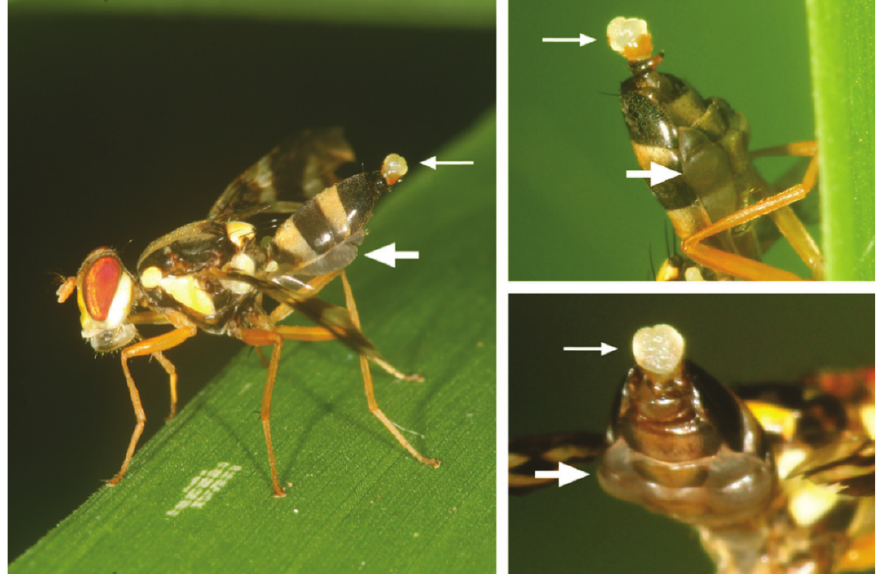
Figure 8. (Left) Typical pheromone calling posture of A. rufipes at the edge of a bamboo leaf. The male is looking downwards; the abdomen is raised; a white pouch (evaginated rectum) is visible at the tip of the abdomen (upper thin arrow); and the lateral parts of the abdomen are distended (lower thick arrow). (Upper right) Enlarged abdomen seen from the ventro-lateral position. (Lower right) Enlarged abdomen seen from the ventro-caudal position. Males searching for mates were permanently moving between bamboo leaves and quickly moving their wings. The wing movements (enantion) were faster than in non-sexual situations (one to two wing beats per second), and the range of the movements was larger. The males remained on a leaf for just a